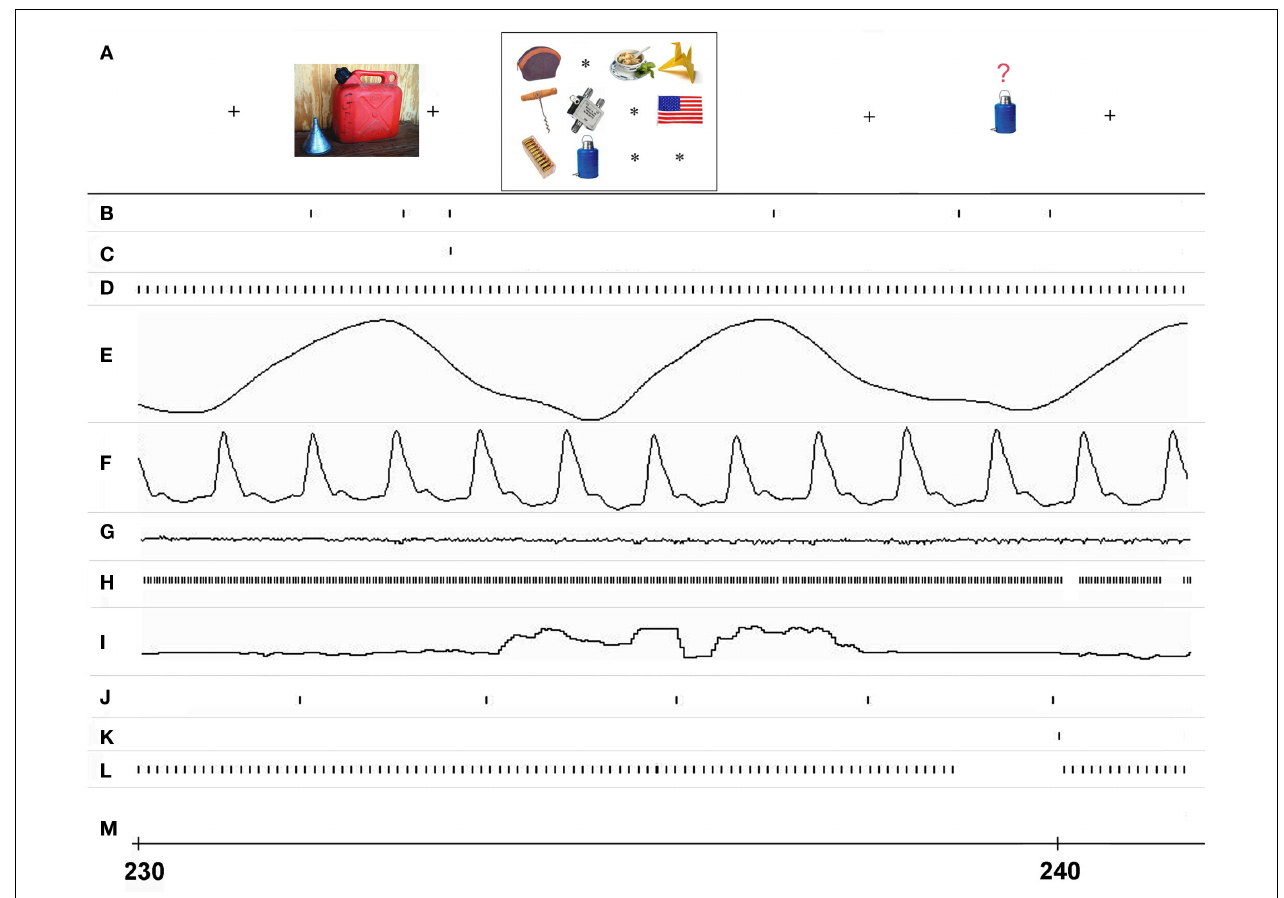
USB A/D device, (E) respiratory data analog signal, (F) cardiac data analog signal, (G) galvanic skin resistance analog data signal, (H) eye-tracker data input events from serial port, (I) vertical eye position signal, (J) MR scanner trigger recorded eachTR interval via serial port, (K) subject button-press input